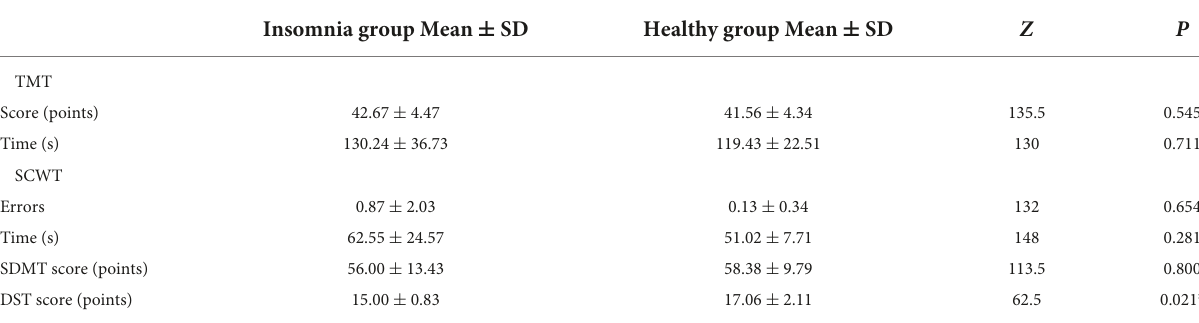
TABLE 2 Cognitive function test measures for